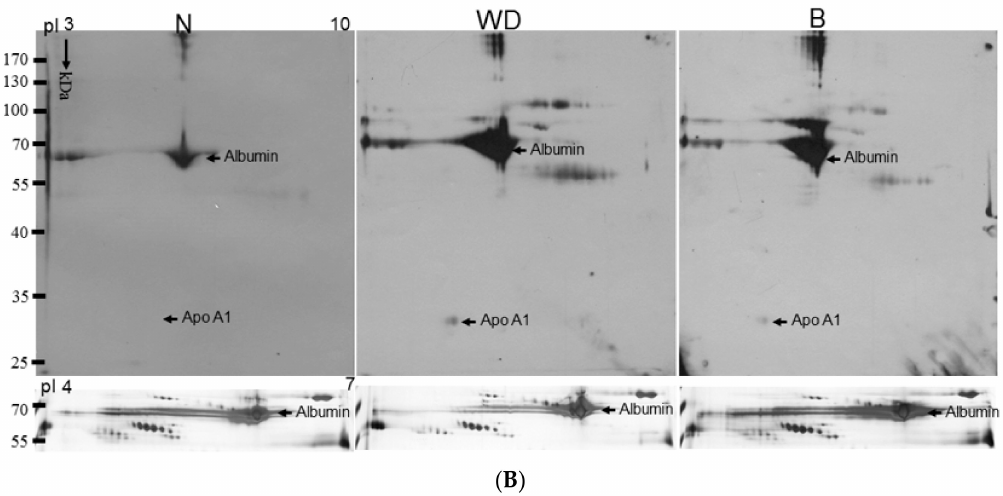
Figure 1. ( A ) In situ oxidase activity of ceruloplasmin oxidase among health donor, heterozygous carriers and homozygous WD patients. The patient (WD) had been undergoing therapy while S and B were diagnosed as health individuals and asymptomatic subjects; however, B started onset six month later. Two paternal samples referred to as F and M, respectively. Marker: protein marker, Std: commercial ceruloplasmin as standard. Albumin is naturally presented as the blue bands after conducting the assay. ( B ) Levels of protein carbonylation. Significantly increased expression of carbonylated proteins were observed in the samples of WD and B compared to the control. Albumin in the lower panels was utilized as a loading